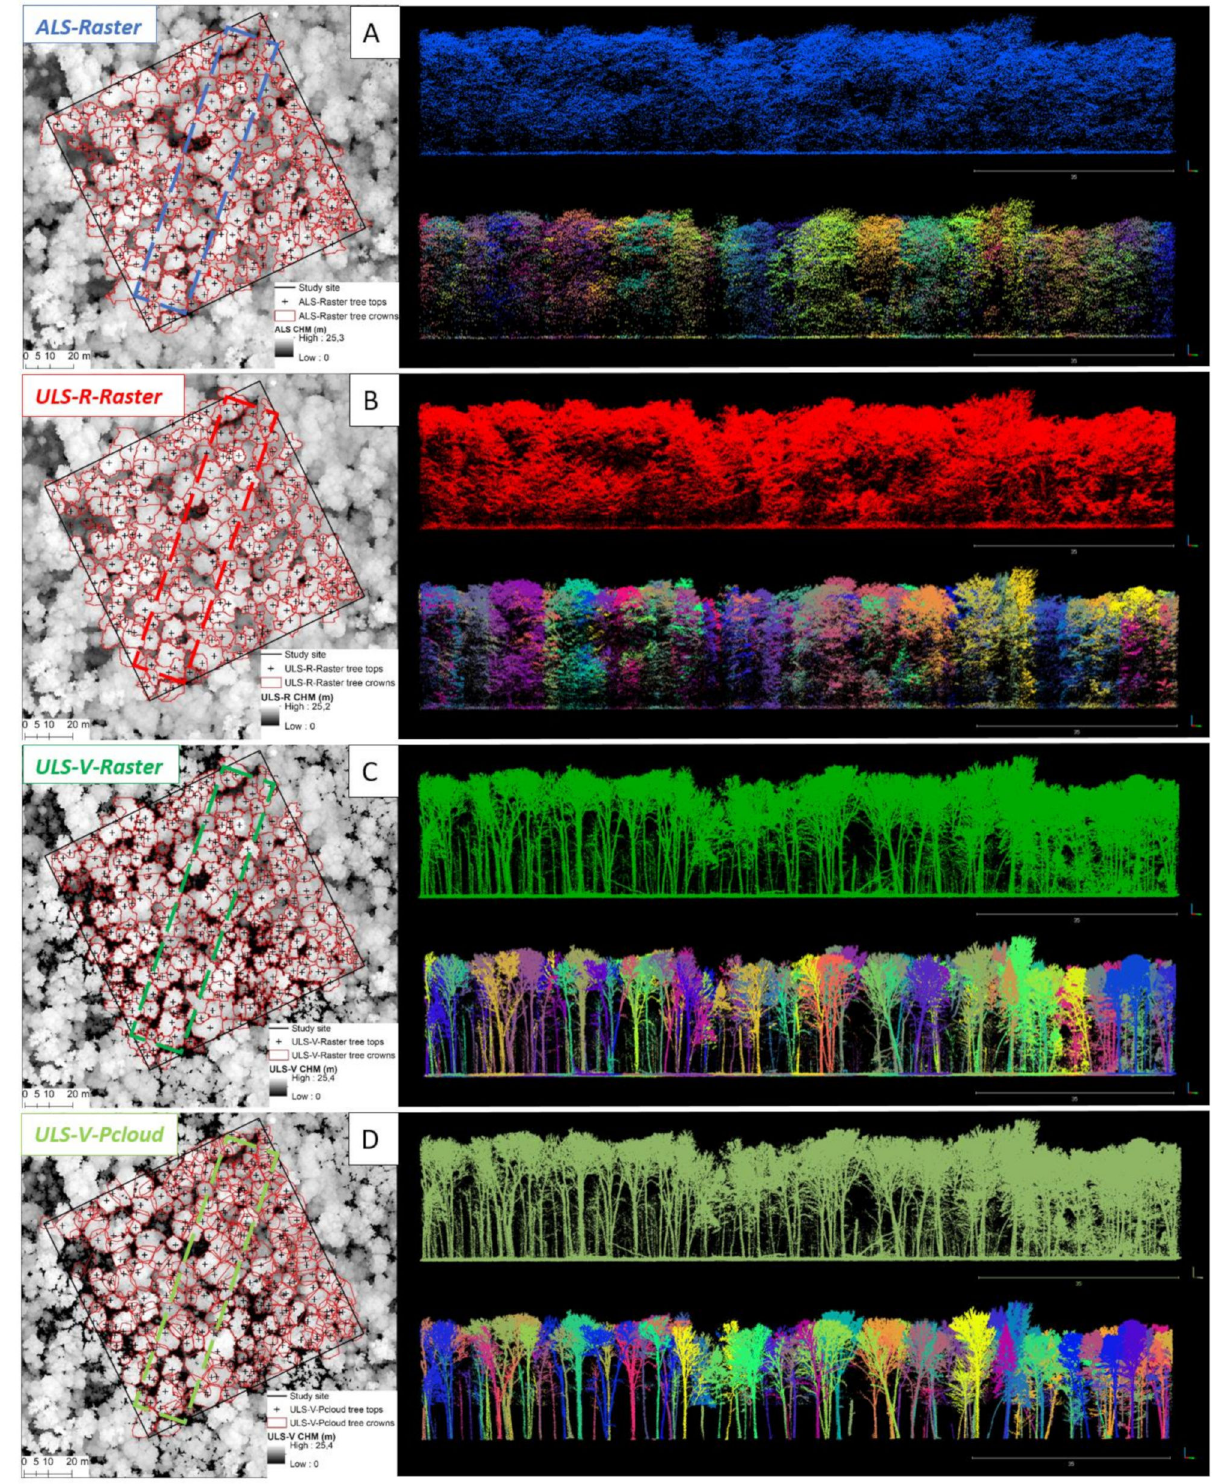
Figure 11. Total number of trees that were detected (Ntrees det ) on the test site from ( A ) ALS-Raster (leaf-on); ( B ) ULS-R- Raster (leaf-on); ( C ) ULS-V-Raster (leaf-off); and ( D ) ULS-V-PCloud (leaf-off). On the left is a graphical representation of the crowns that were identified by the ITD algorithm over the CHM. On the right is a representation of the original normalized point cloud (upper image) and the ITD results (lower image) from a slice of points of 140 m × 20 m across the stand (illustrated by dotted lines in the left hand